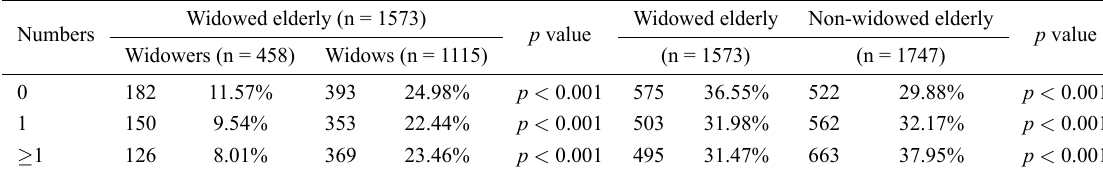
Table 4. Chronic Diseases of the widowed elderly.